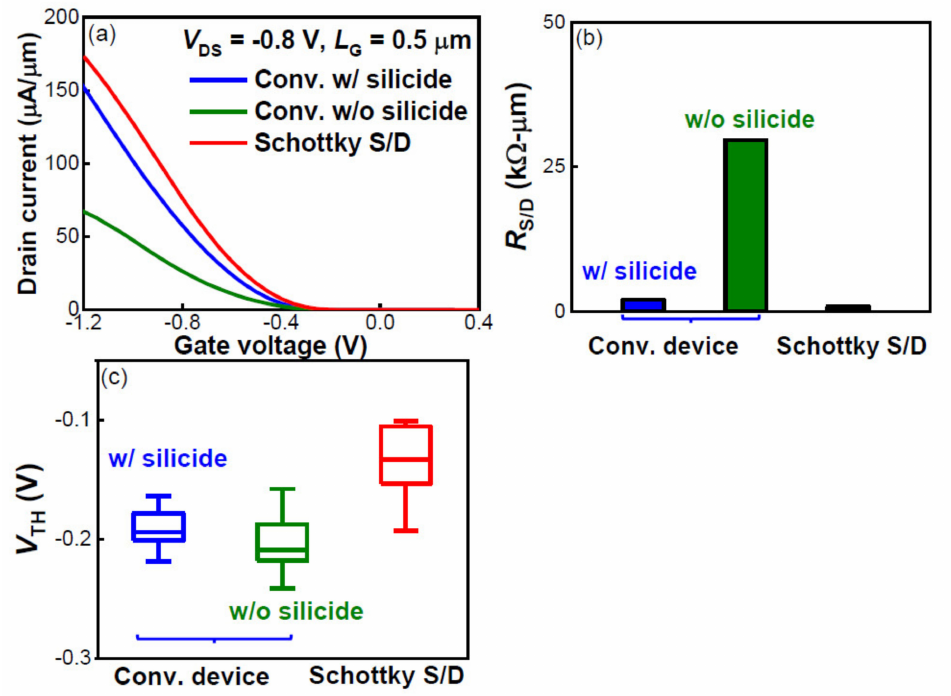
Figure 7. Comparison of ( a ) I DS at V DS = − 0.8 V, ( b ) R S/D and ( c ) V TH between low-temperature Schottky S/D device and conventional (conv.) high-temperature